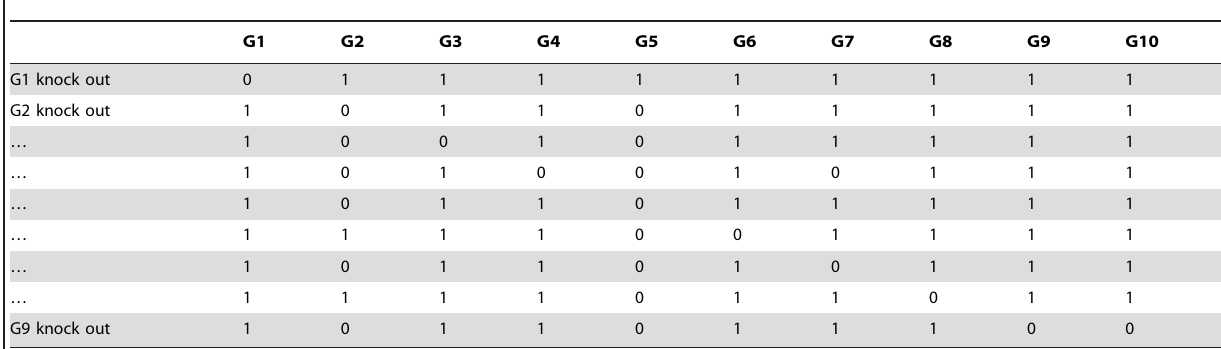
Table 9. Steady States used to get regulators of Gene